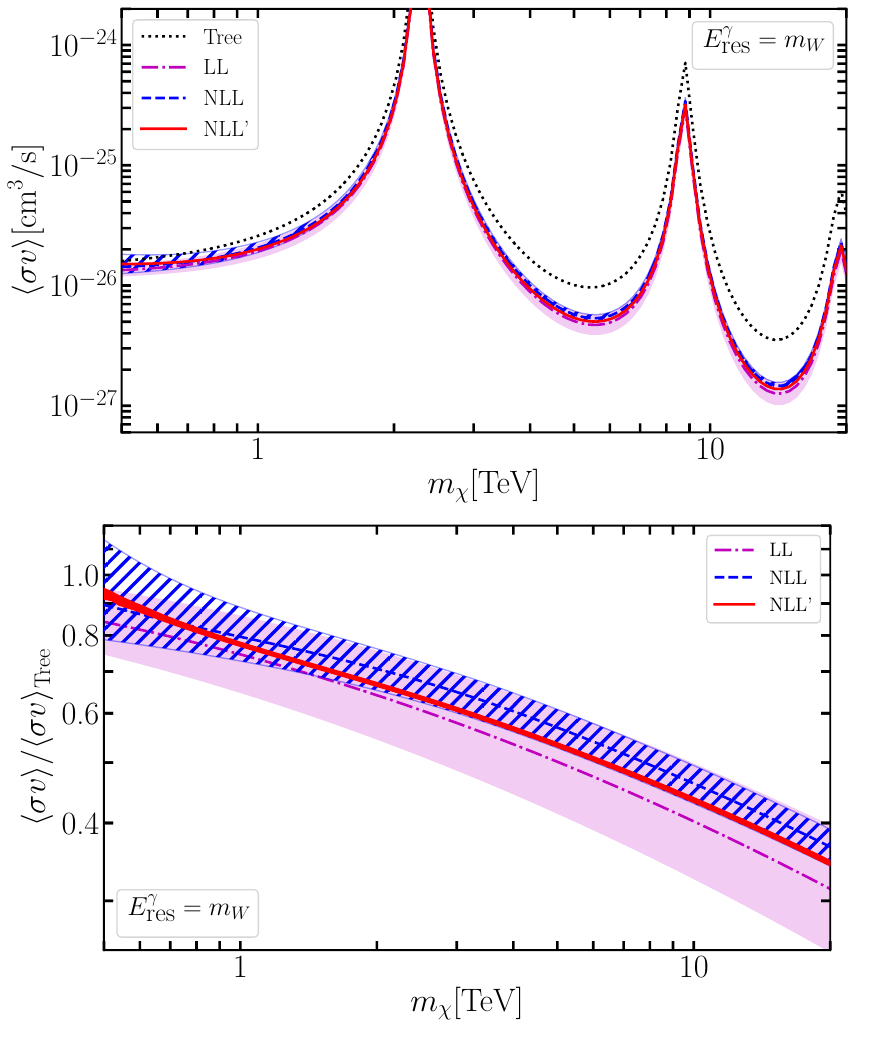
from the endpoint m (cid:31) in the tree res